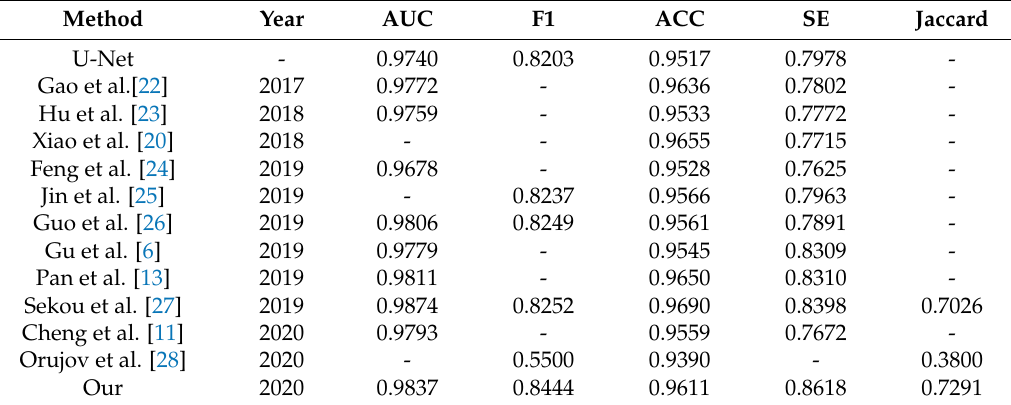
Table 1. Evaluation of DRIVE Results.